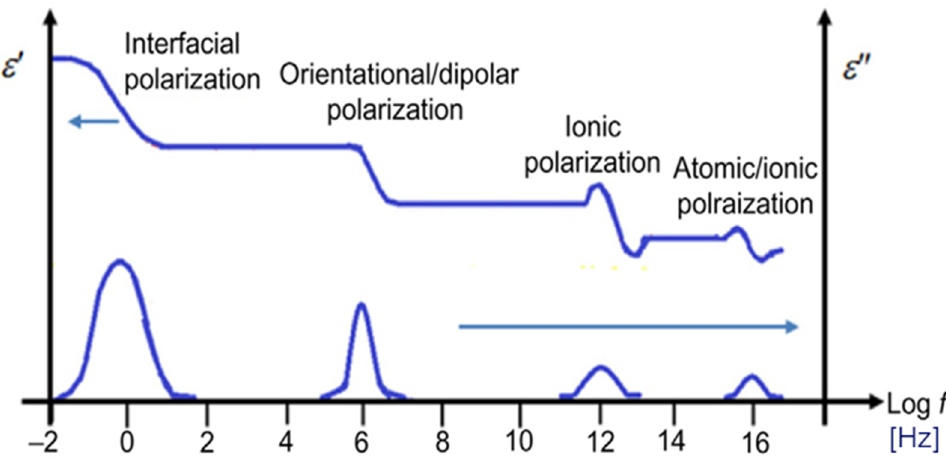
Figure 1. Di ff erent polarization e ff ects in solid materials Figure 1. Different polarization effects in solid materials [32].